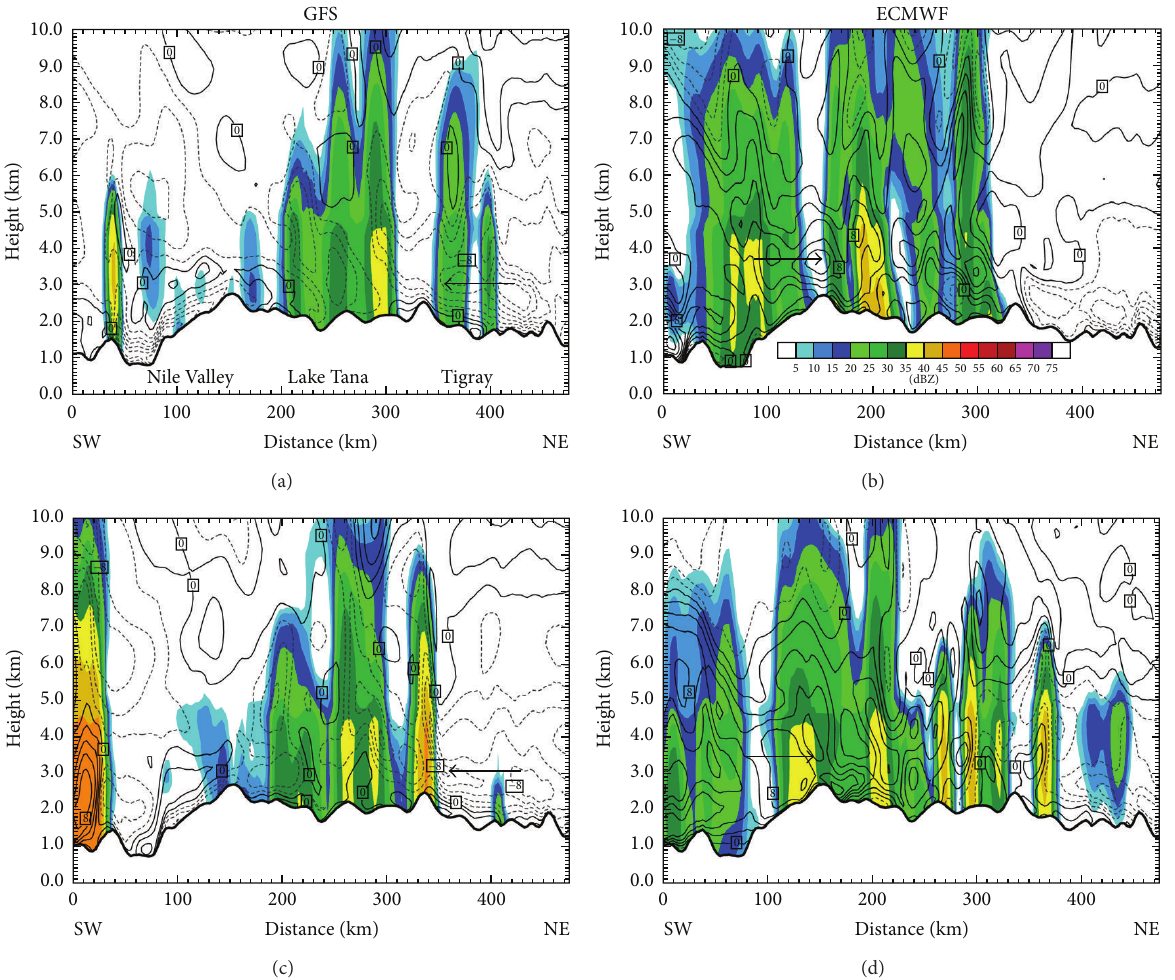
Figure 8: High resolution WRF simulated vertical NE-SW section (cf. Figure 9(a)) of meridional (V) wind (contour interval 2m/s, dashed southward) and radar reflectivity (shaded according to scale upper right) at (a) 20:00 LST and (b) 22:00 LST; initialization with GFS (left) and ECMWF (right). Arrows highlight contrasting meridional